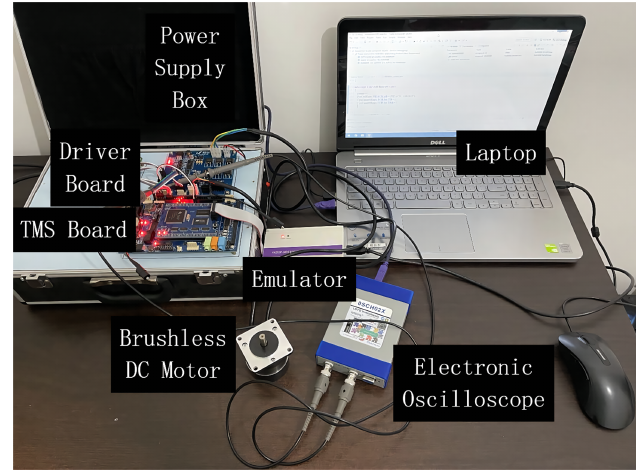
Figure 4. Experiment platform of the BLDC motor drive system.